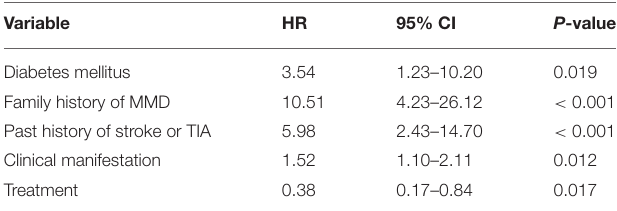
TABLE 5 | The significant predictors of future stroke events in adult patients with moyamoya disease via a multivariate Cox regression analysis.